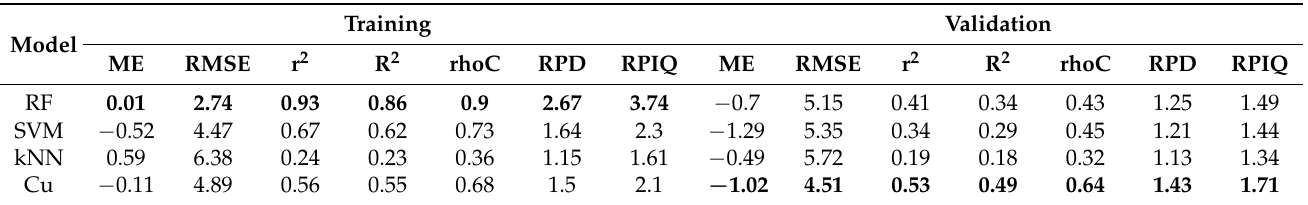
Table 4. Performance results of the applied models to predict CEC and clay activity in the study area (bold values indicate high model performance).